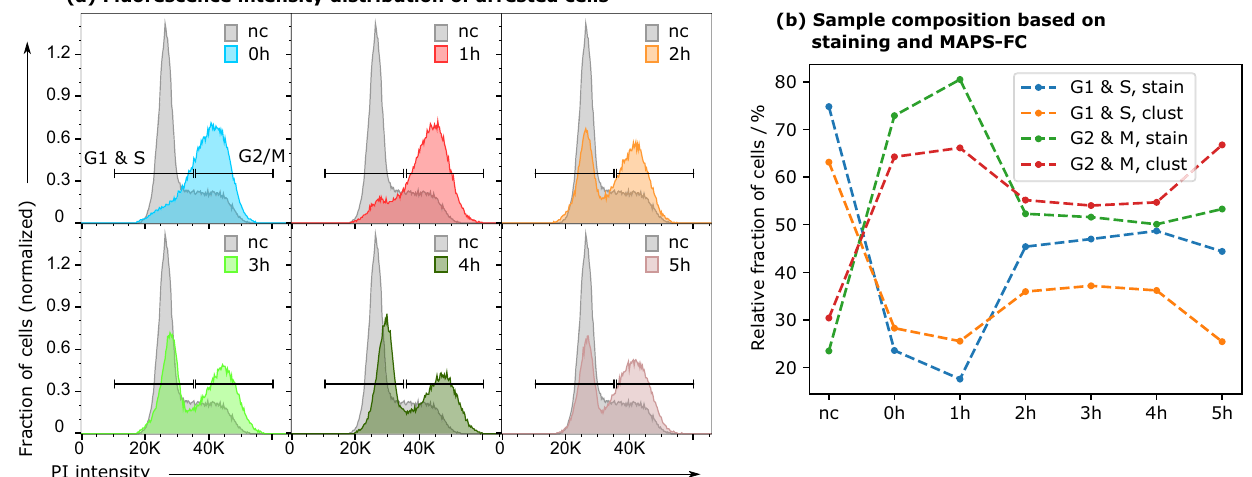
Fig. 4 Analysis of sample composition by wavelet-clustering upon cell cycle arrest. a Intensity histograms of PI staining in the samples measured at indicated time points after release from G2/M arrest, and the control sample (nc). To quantify the fraction of cells in G1 & S or G2/M phase, gates were de fi ned as indicated in the histograms. b Sample composition at indicated time points. Orange and red curves show fractions of arrested but otherwise untouched cells in the respective cell cycle phase determined with MAPS-FC and cluster analysis. Blue and green curves show fractions of fi xed and stained